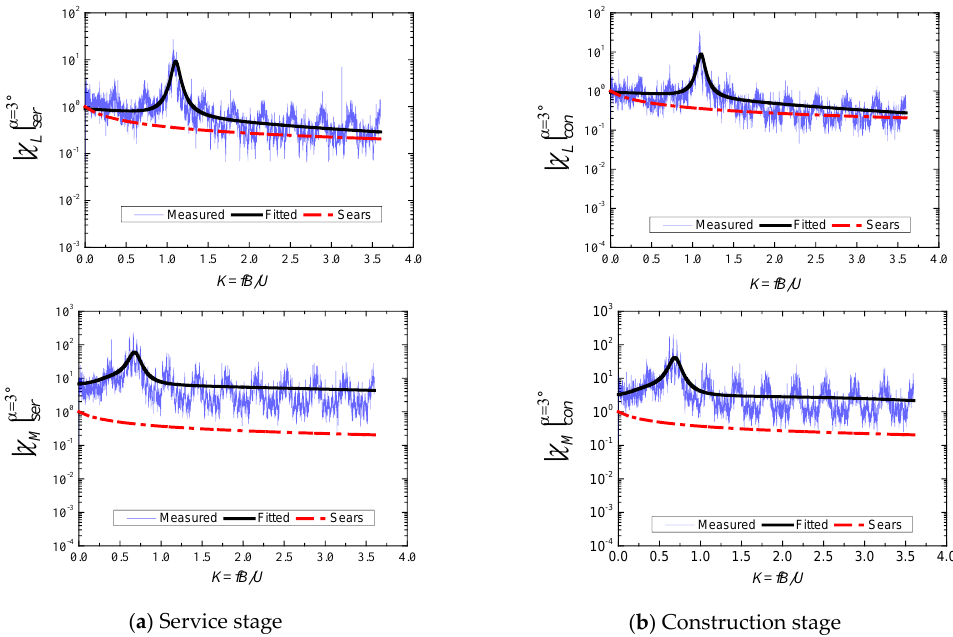
Figure 9. AAFs identified for the DDTG under the service and construction stages at α = 3 ◦ .